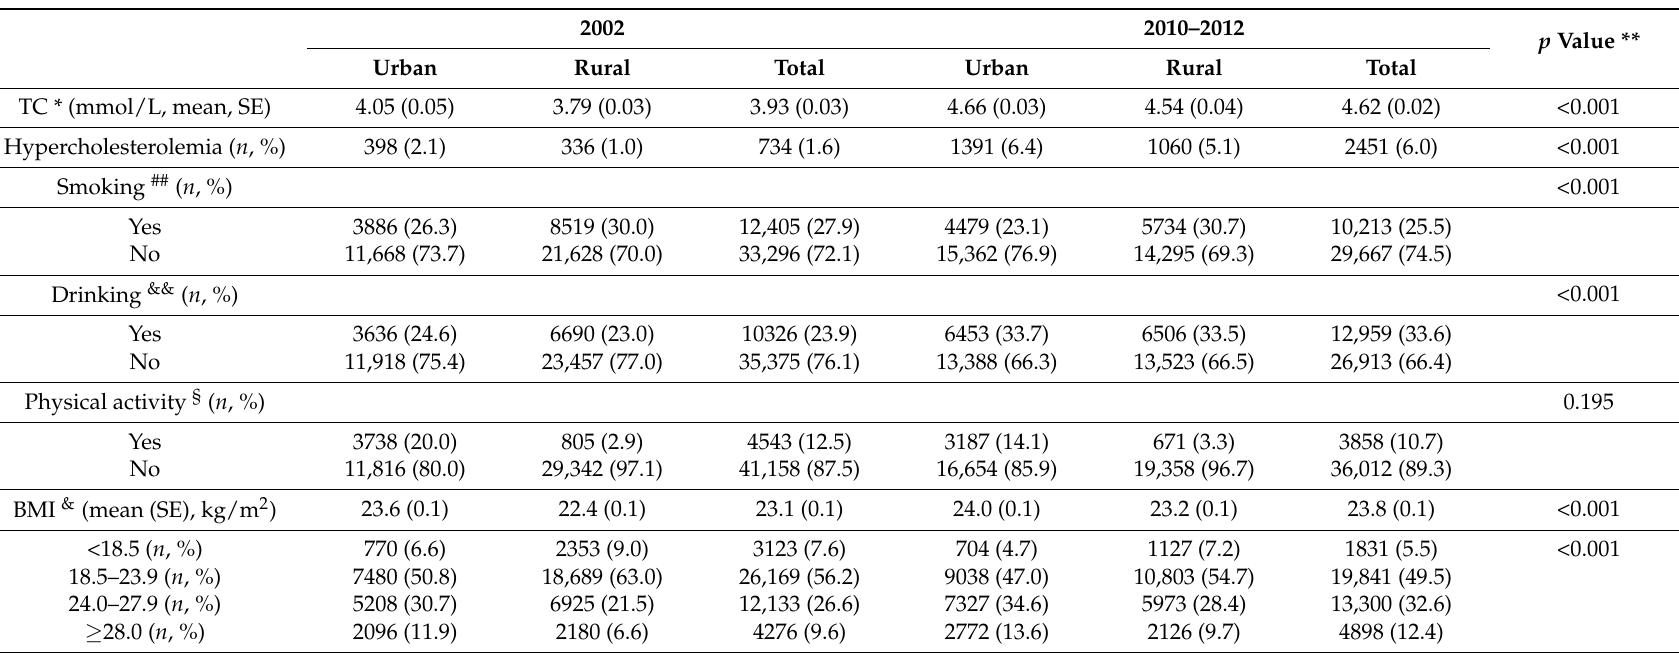
Table 2. Lifestyle and serum total cholesterol concentrations of participants in 2002 and 2010–2012 surveys #